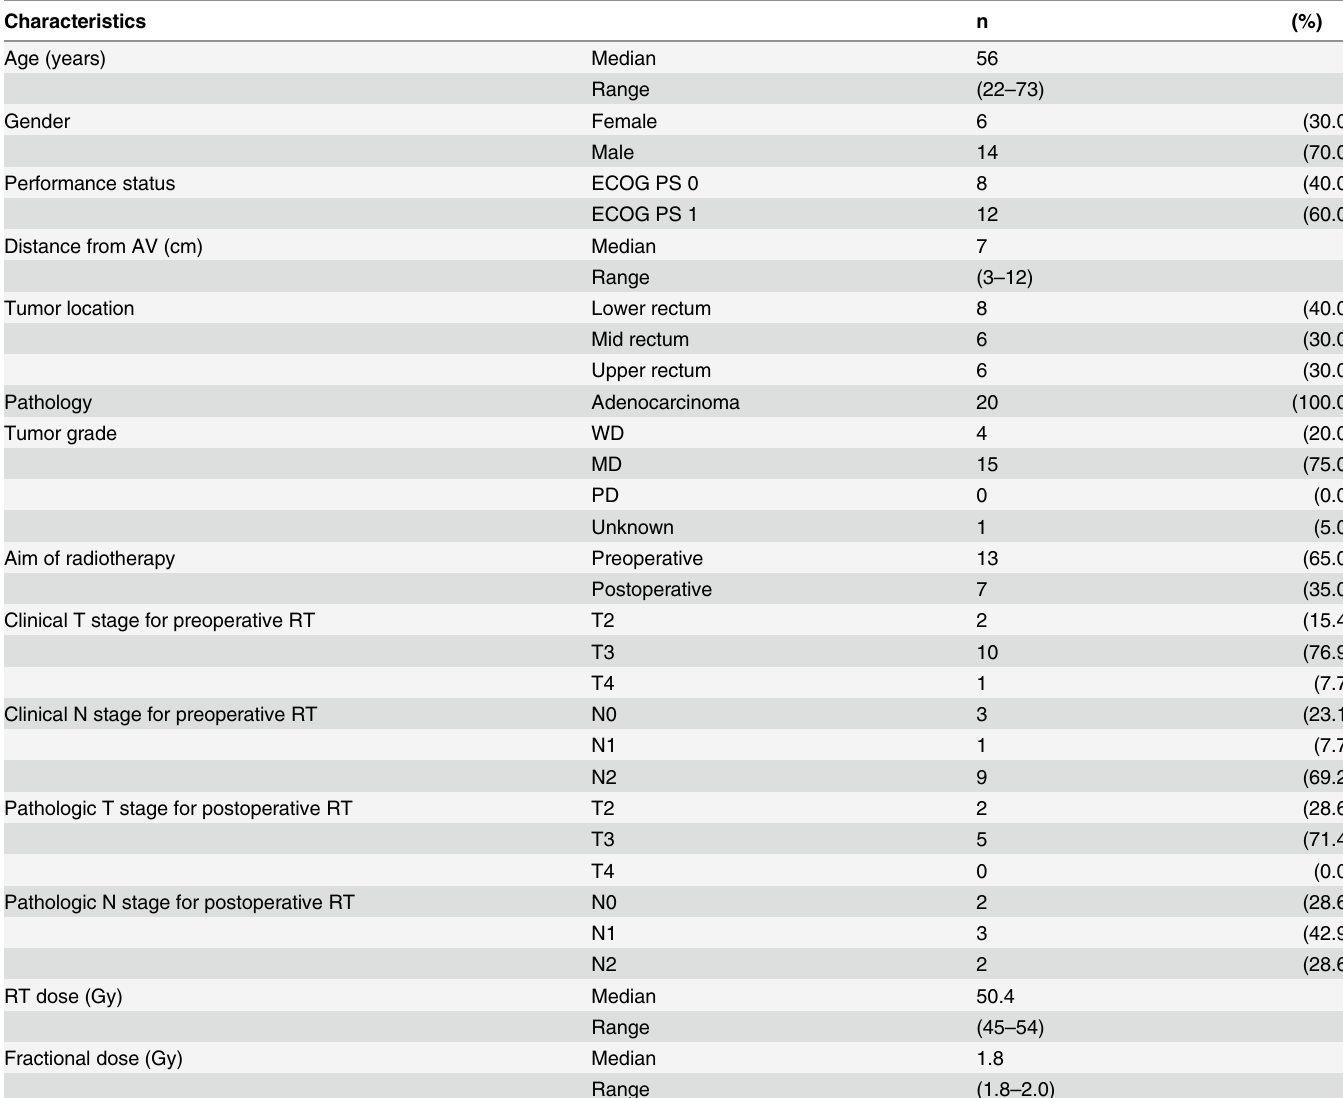
Table 1. Patient